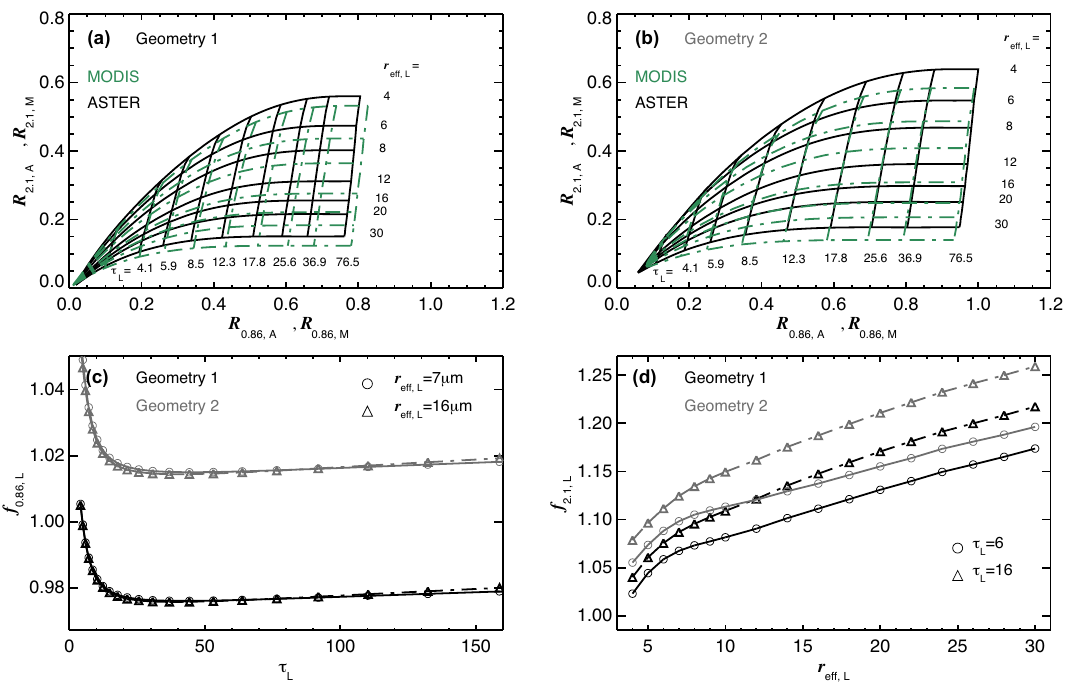
Figure 5. Example lookup table (LUT) for ASTER (solid black lines) and MODIS (dash-dotted green lines) for (a) “Geometry 1” and (b) “Geometry 2”. See text for details on the specific solar and viewing geometries. (c) The reflectance ratio f 0 . 86 , L of ASTER to MODIS VNIR reflectances as a function of cloud optical thickness τ L for Geometry 1 (black line) and Geometry 2 (gray line). Simulations for two different values of effective droplet radius r eff , L are indicated by different symbols. (d) The reflectance ratio f 2 . 1 , L of ASTER to MODIS SWIR reflectances as a function of r eff , L for Geometry 1 and Geometry 2. Simulations for two different values of τ L are indicated by different